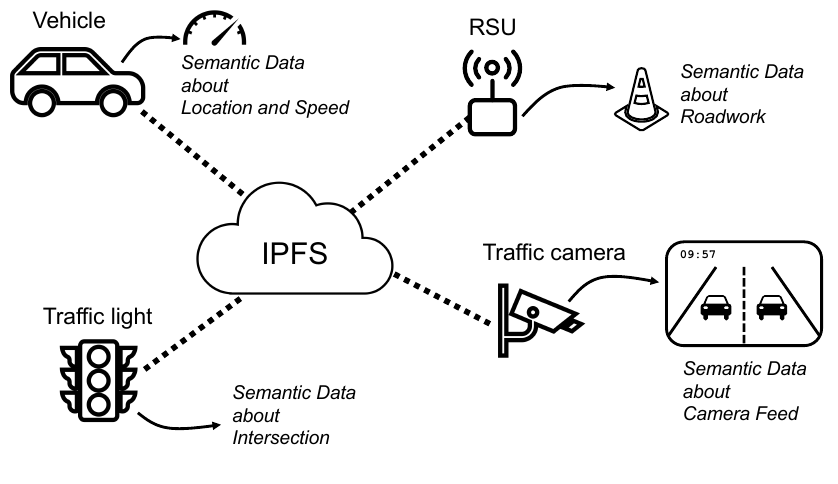
Figure 1. Vehicles, road-side units (RSUs), and other IoT devices (e.g., traffic cameras and traffic lights) connected to the peer-to-peer (P2P) Inter-Planetary File System (IPFS) network to share and retrieve semantic